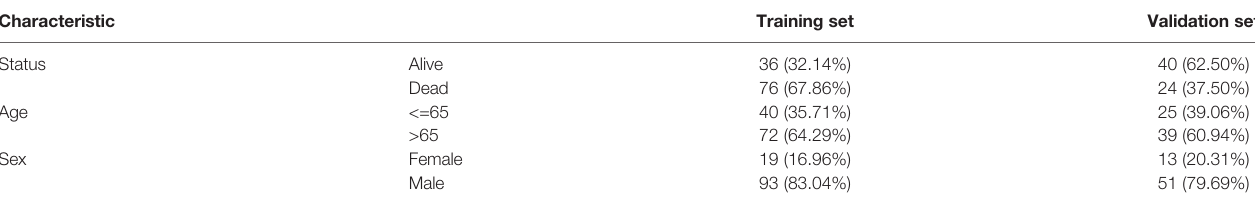
TABLE 1 | The basic information of IPF patients.